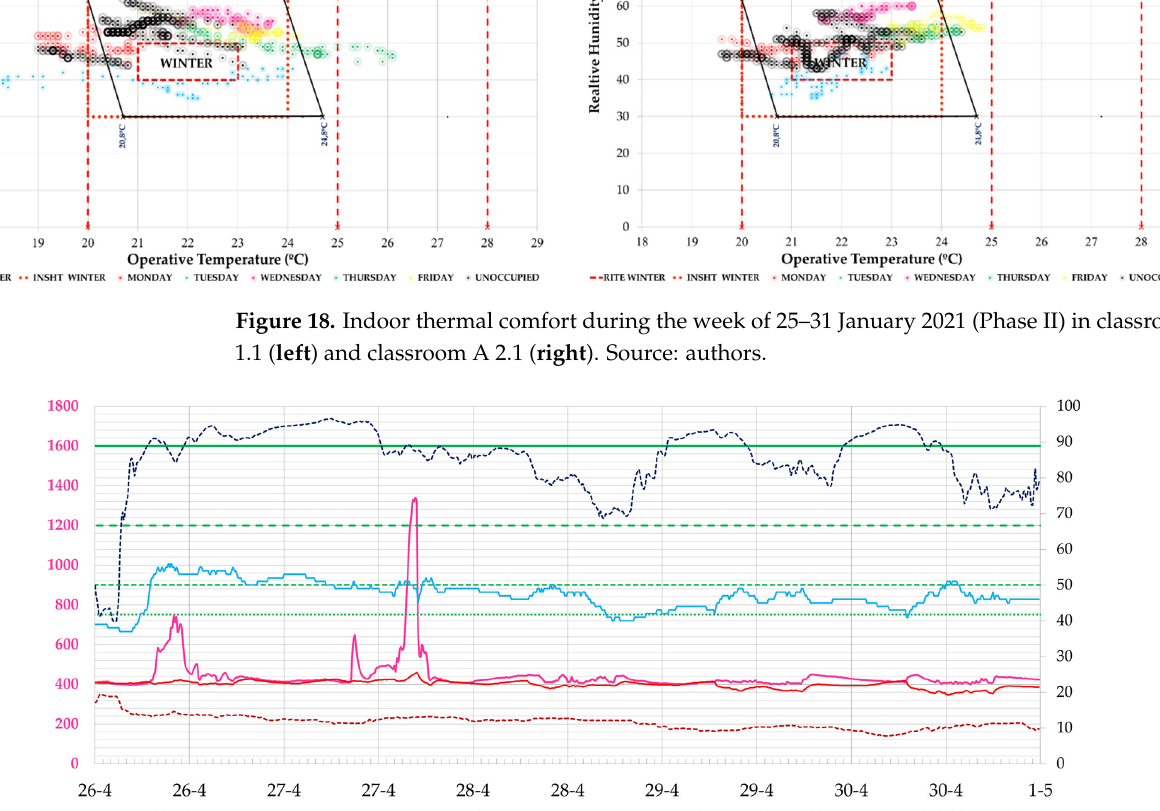
Figure 18. Indoor thermal comfort during the week of 2021-01-25 to 2021-01-31 (Phase II) in class- room A 1.1 ( left ) and classroom A 2.1 ( right ). Source: authors.